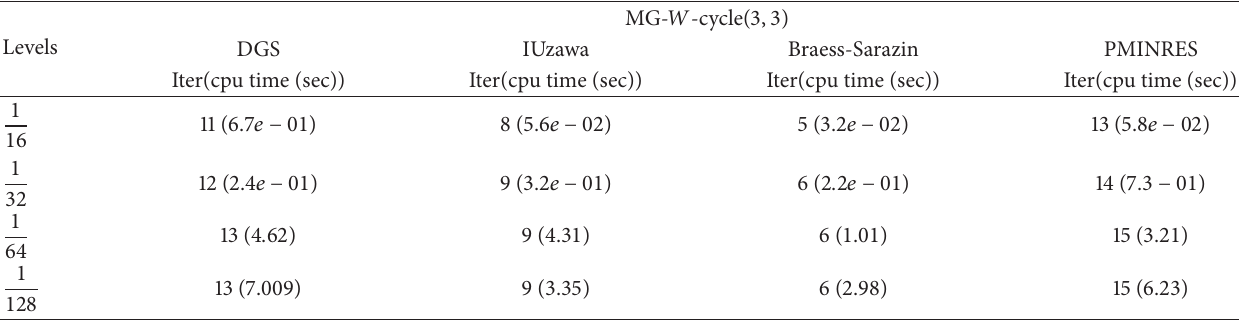
Table7:NumberofiterationsandCPUtimeformultigrid( 𝑊 -cycle)withdifferentsmoothersandusingone V -cyclemultigridpreconditioner ̂𝐴 ̂𝑆 approximation (for both and ) at different levels of refinement, tolerance = 10 −6 .